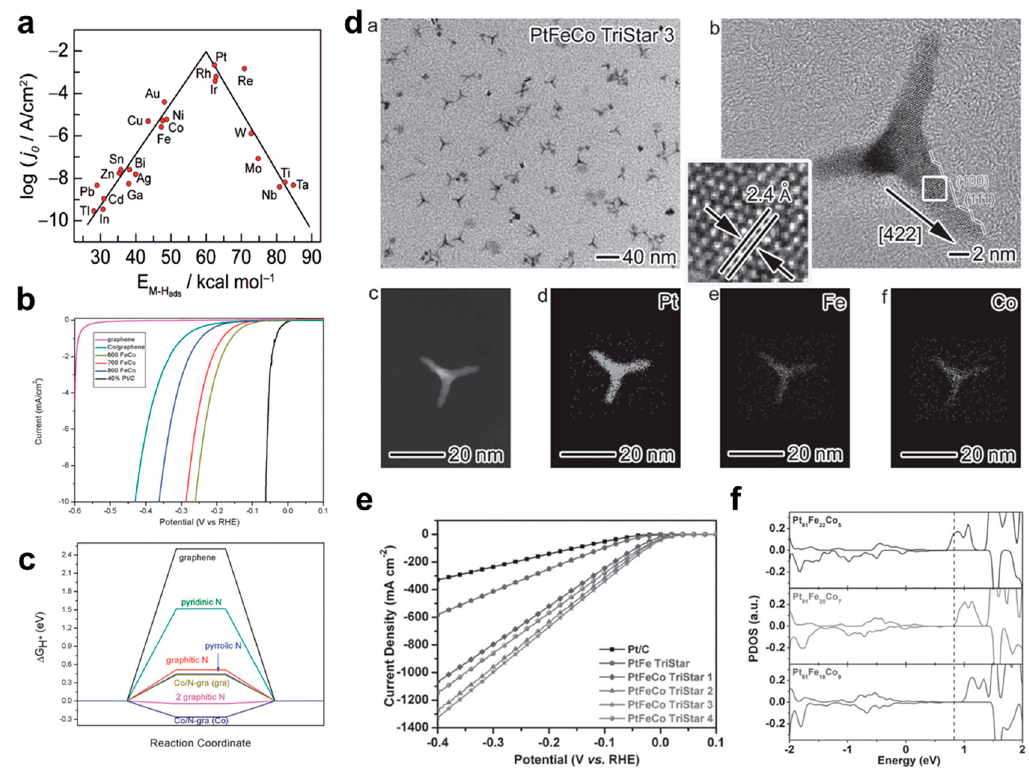
Figure 9. ( a ) The typical volcano curve for the hydrogen evolution reaction (HER) performance of the metal materials in acid solution, reproduced with permission from [53]. Copyright American Chemical Society, 2010. ( b ) The polarization curves of FeCo alloy samples of different temperatures; ( c ) calculated Δ G H * diagram of some models; the words in the brackets differ from the H* adsorbed on the graphene side or Co 4 side, reproduced with permission from [43]. Copyright Royal Society of Chemistry, 2015. ( d ) TEM, HRTEM, and STEM mapping images of Pt 81 Fe 28 Co 10 nanostructures in a TriStar shape; ( e ) Polarization curves for Pt-based alloy TriStar nanostructures in different chemical compositions compared with Pt / C at the same total metal loading weights in 0.5 M H 2 SO 4 (aq) electrolyte; ( f ) calculated projected density of states (PDOS) diagrams for the d orbitals of Pt atoms in three types of PtFeCo lattices in neutral condition, reproduced with permission from [54]. Copyright Wiley, 2016.